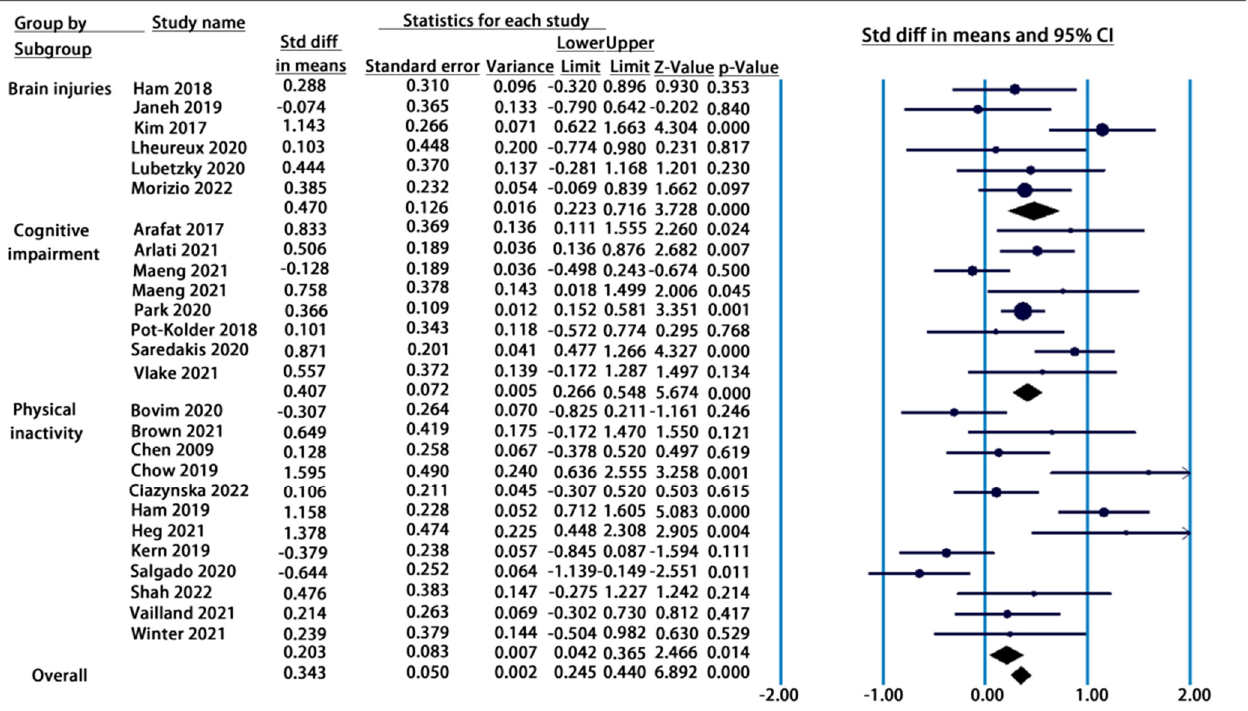
Figure 3. Forest plot of symptom subgroups for SSQ total scores [18–36,37–43].